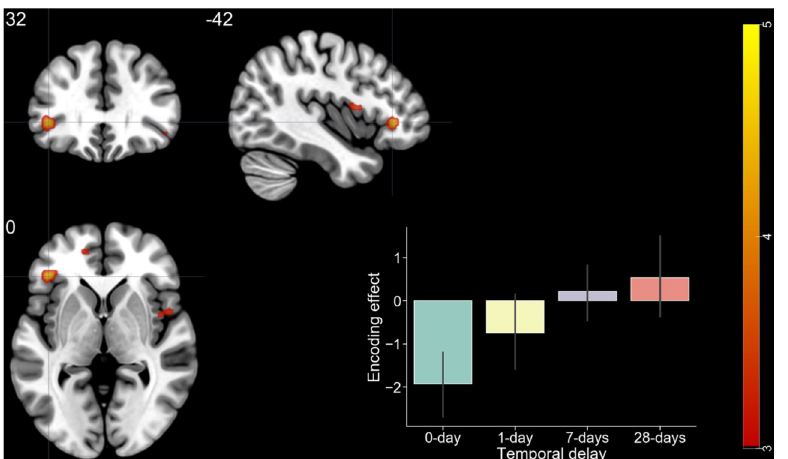
Fig 7. fMRI results: Encoding-retrieval overlap. Color bar indicates t-statistics, bar plot indicates SME (beta values of Remembered subtracted by Forgotten) of medial frontal gyrus (-42, 32, 0). Error bar indicates standard deviation. https://doi.org/10.1371/journal.pone.0249290.g007 rather than TD, it would not support our results since our study does not require choosing between delayed and immediate rewards. However, a study which examined the prediction of future rewards outside the intertem- poral decision-making paradigm also reported that in the long vs. short delay contrast, the ventrolateral PFC (vlPFC), insula, dorsolateral PFC (dlPFC), dorsal premotor cortex, and the inferior parietal cortex are activated [44]. In addition, a study that examined single-neuron activity of rats revealed neurons in the OFC/ventromedial PFC (vmPFC) which fire more